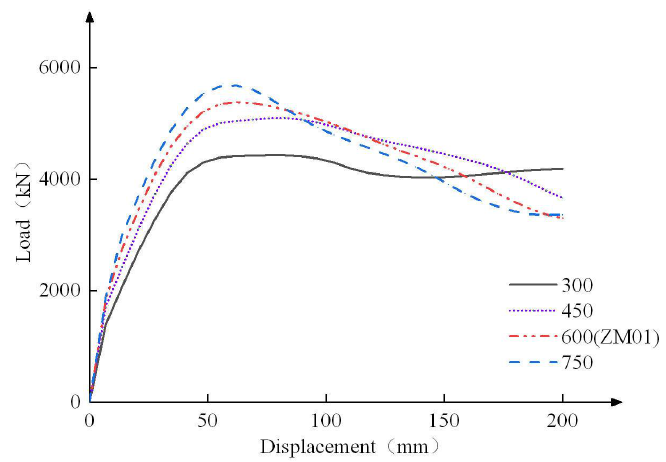
Figure 18. Influence of the depth of column cap.